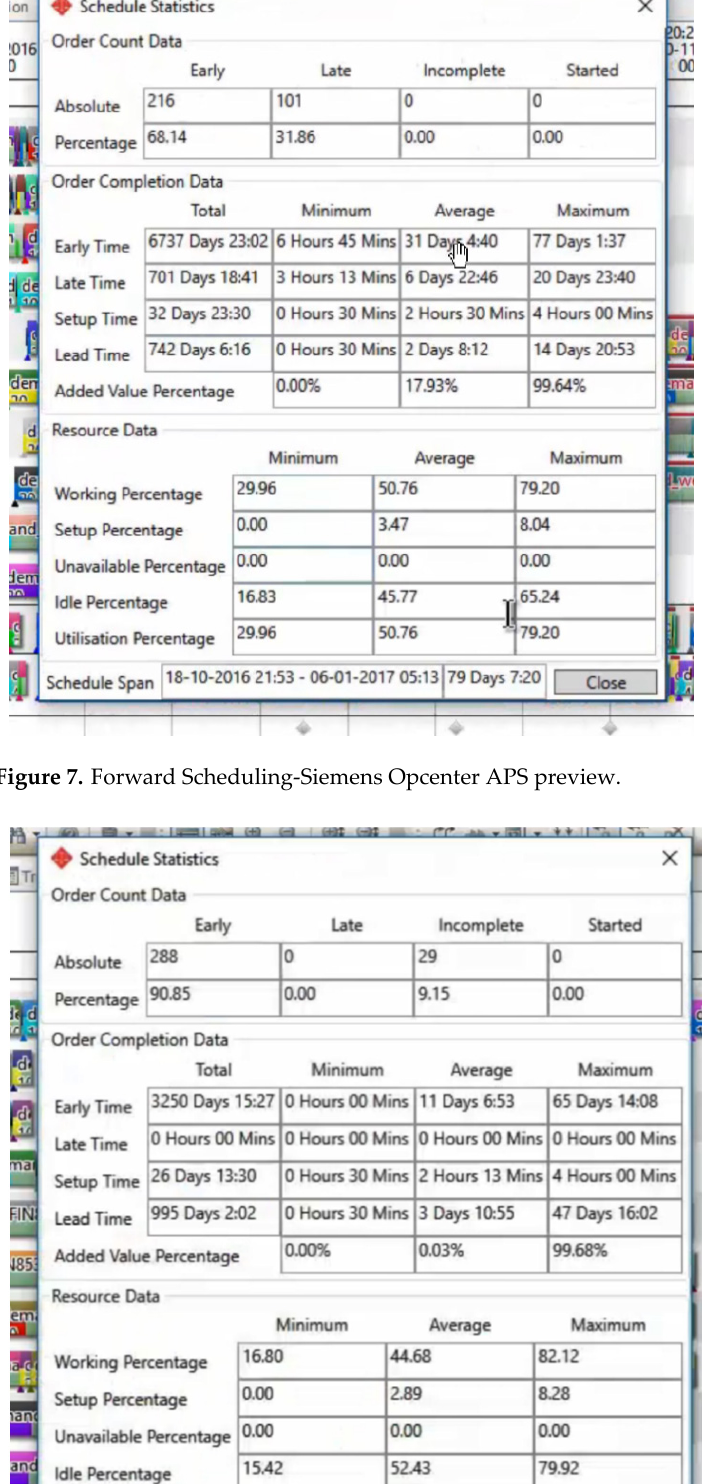
Figure 8. Backward scheduling-Siemens Opcenter APS.